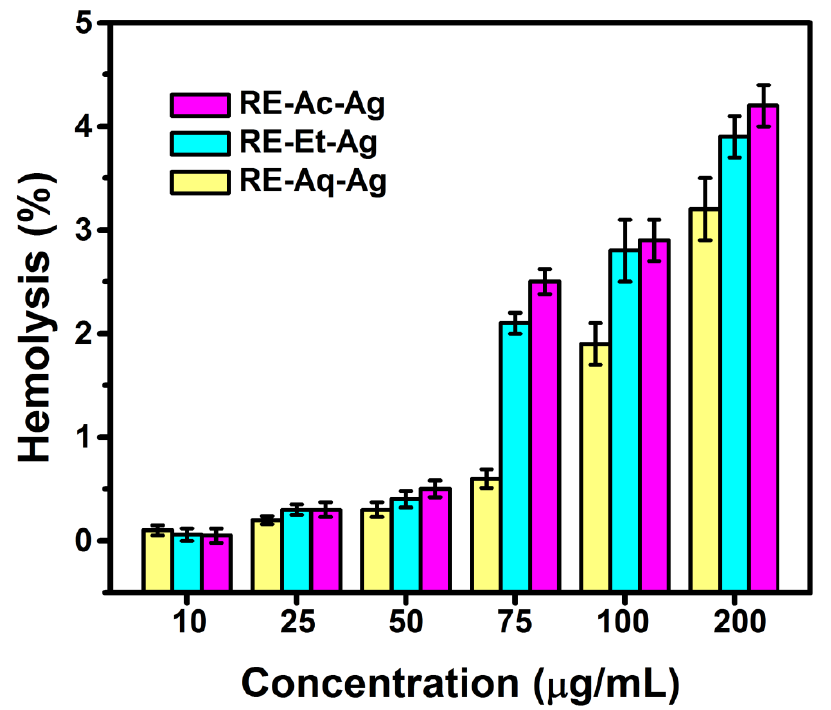
Figure 5. Hemolysis results of green synthesized silver nanoparticles (values with mean + SD, n = 3).